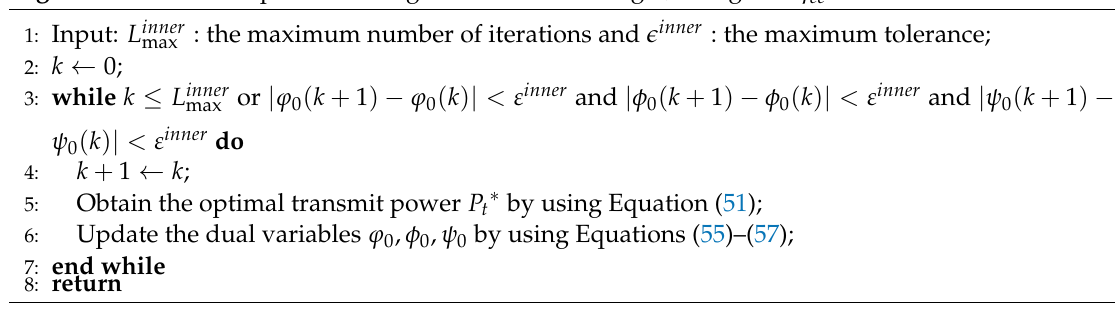
Algorithm 4 Inner Loop Iterative Algorithm for obtaining P t ∗ for given η TS